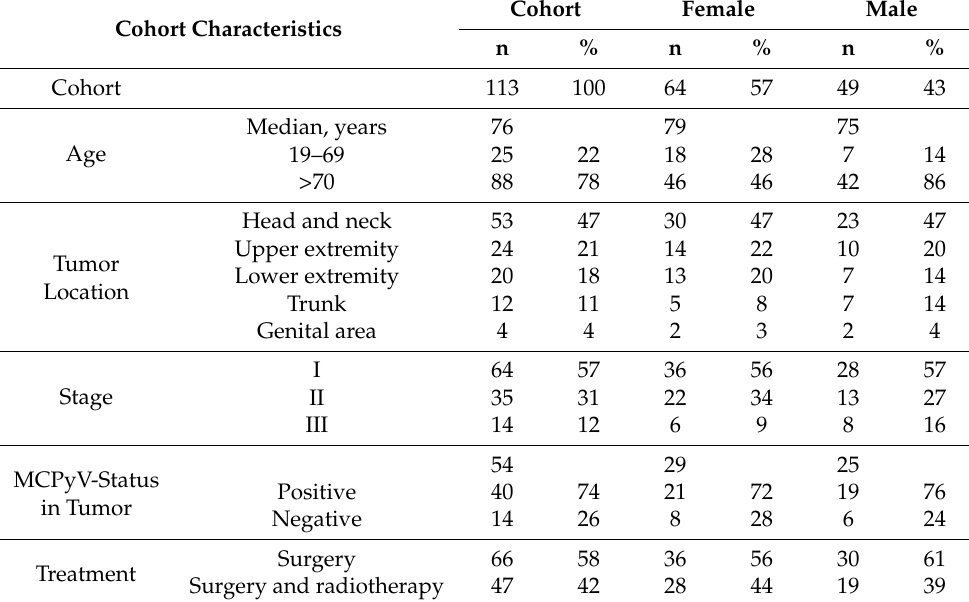
Table 1. Patients clinical characteristics and